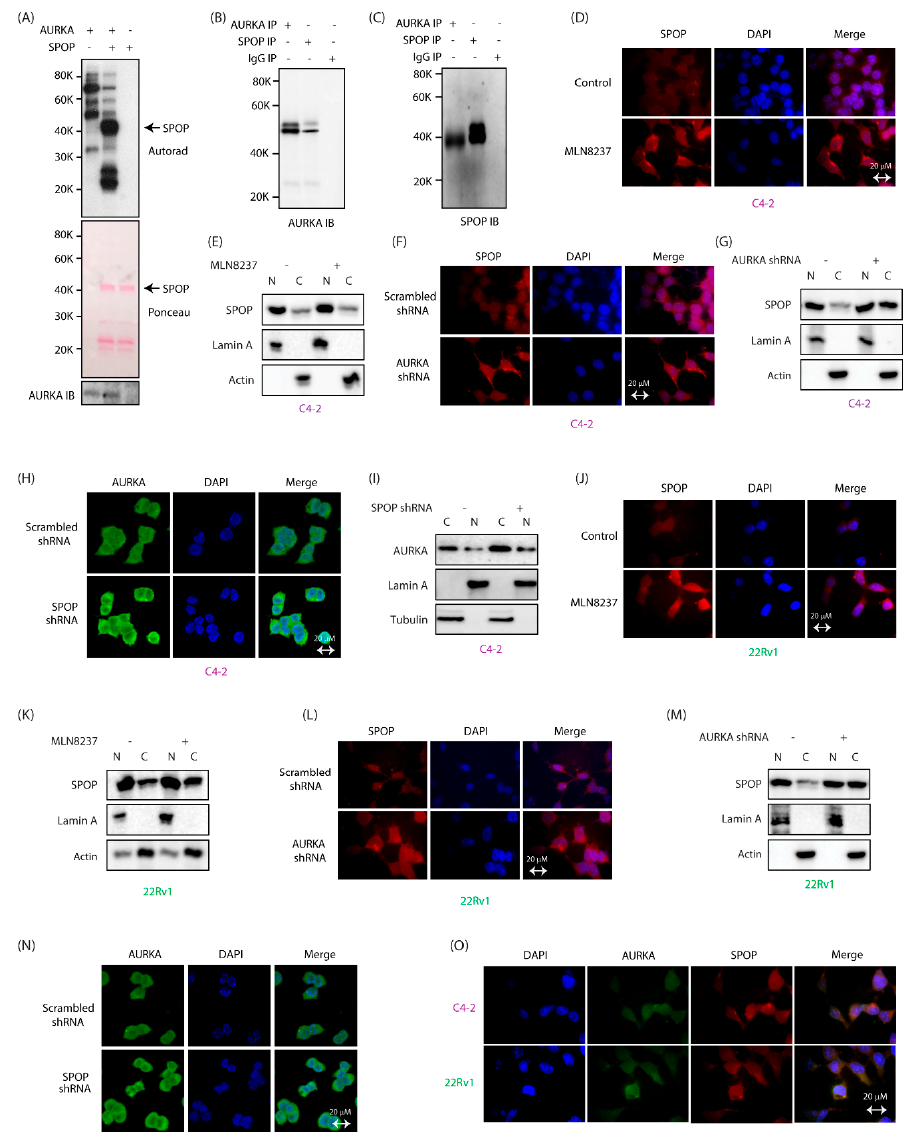
Figure 1. AURKA binds and phosphorylates SPOP and regulates its subcellular localization in CRPC cells. ( A ) SPOP is phosphorylated by AURKA in vitro. AURKA-TPX2 was incubated with [ 32 P]ATP in a kinase buffer in lane 1. Lane 2 shows incubation of 6x-His-SPOP, AURKA-TPX2 and [ 32 P]ATP in a kinase assay buffer for 30 min. Lane 3 shows 6x-His-SPOP incubated with [ 32 P]ATP. ( B ) AURKA associates with SPOP in cells. SPOP immune complex was isolated from C4-2 cells, and AURKA binding analyzed (lane 2). AURKA IP (lane 1) was used as a positive control, and IgG IP (lane 3) was used as a negative control. ( C ) AURKA immune complex was isolated from C4-2 cells, and SPOP binding analyzed (lane 1). SPOP IP (lane 2) was used as a positive control, and IgG IP (lane 3) was used as a negative control. ( D ) AURKA inhibition using MLN8237 slightly alters the subcellular localization of SPOP in C4-2 cells. C4-2 cells were treated with 1 μ M MLN8237 for 12 h, and subcellular localization of SPOP analyzed using SPOP-specific antibody (red). DAPI is shown in blue. ( E ) Subcellular fractionation of DMSO-treated and MLN8237-treated C4-2 cells do not show a significant change in SPOP’s residence upon AURKA inhibition. C4-2 cells were treated with DMSO or MLN8237 (1 µ M) for 12 h, followed by fractionation. ( F ) AURKA knockdown increases the cytoplasmic localization of SPOP. C4-2 cells were treated with control or AURKA shRNA for 30 h, fixed and stained with SPOP antibody (red) and DAPI (blue). > 100 cells were analyzed from multiple random frames. ( G ) Subcellular fractionation of scrambled shRNA-treated and AURKA shRNA-treated C4-2 cells confirm increased cytoplasmic localization of SPOP upon AURKA knockdown. C4-2 cells were